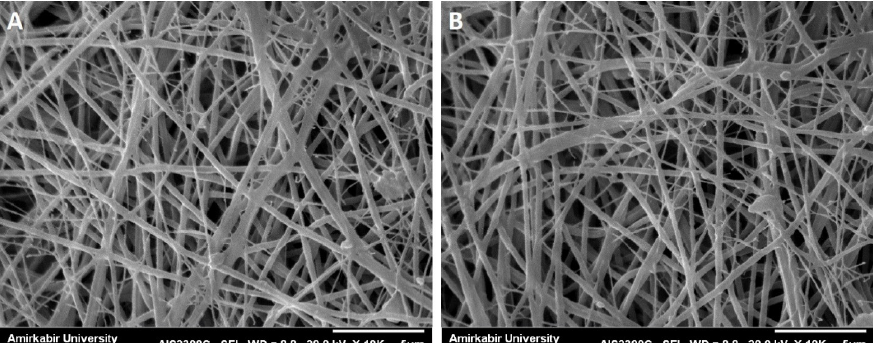
Figure 2. SEM of the CS-GEL (A) and CS-GEL/58SBG-NPs (B) crosslinked fibers.